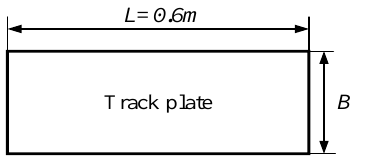
Figure 16. Schematic diagram of the track plate L and B .